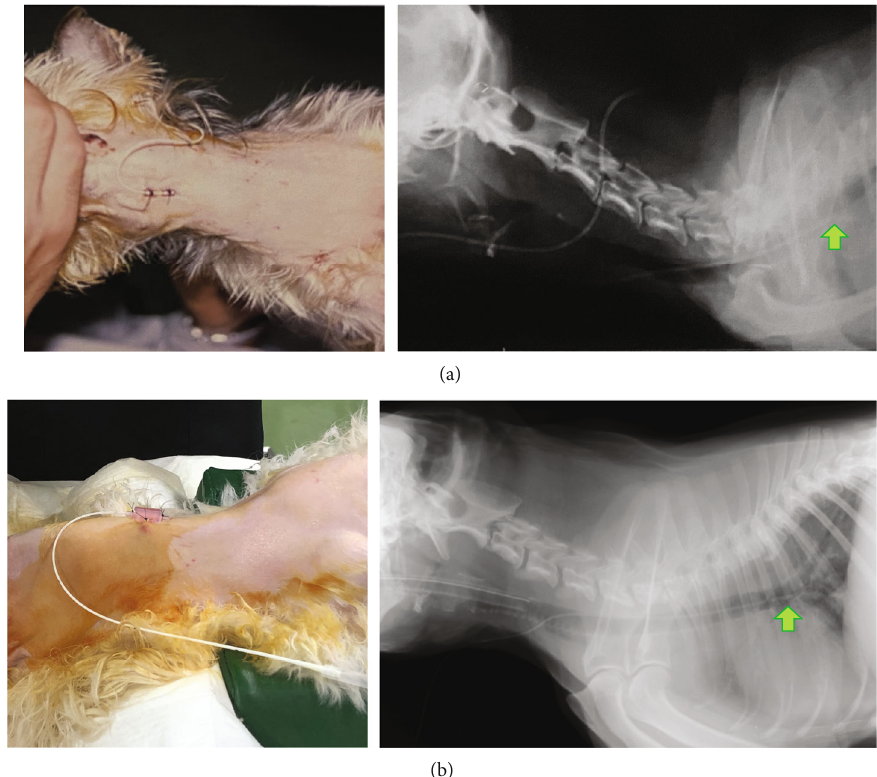
Figure 2: Photographs and X-ray images of cases 1 and 2: (a) photographic images of the neck showing transtracheal catheter placement after transsphenoidal surgery and (b) X-ray images of the neck taken to check the placement of the transtracheal catheter. Arrows in the X-ray images indicate the apex of the catheter in the thoracic